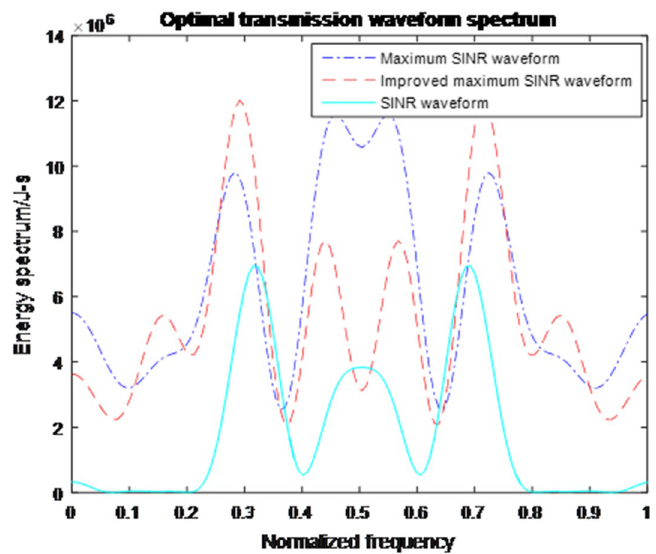
Fig. 8 Transmission waveform spectrum of radar with maxmin